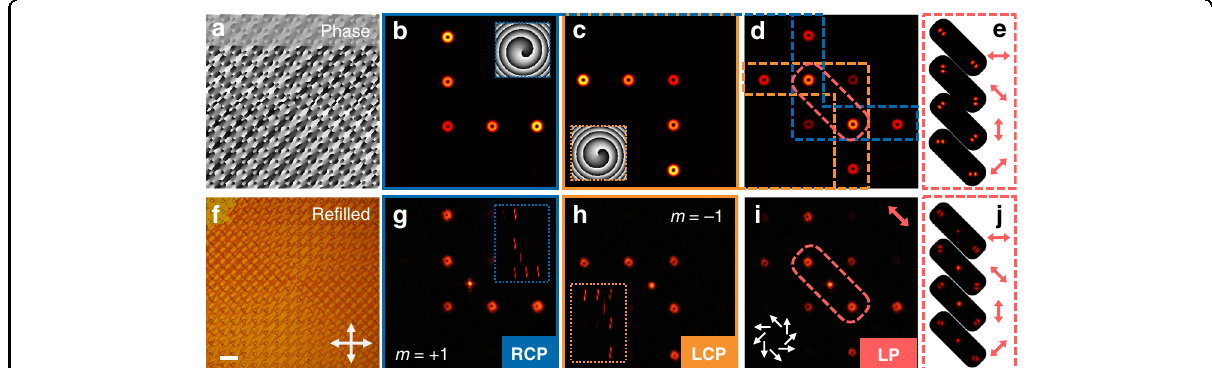
Fig. 4 Simulations and experimental demonstration of the OV hologram by opposite-chirality-coexisted superstructures. a Designed phase pattern and f corresponding re fl ective micrograph of the re fi lled state. The scale bar is 100 μ m. b – e Simulated and g – j experimental diffraction patterns of the sample under different incident polarization: b , g RCP, c , h LCP, and d , e , i , j 135° LP, respectively. The phase pro fi le of an OV order and the converted diffraction patterns after the cylindrical lens are inserted in b , c and g , h , respectively. The polarization distribution of the vector beams in the marked orders is inserted in i . e , j Marked diffraction patterns with different orientations of the